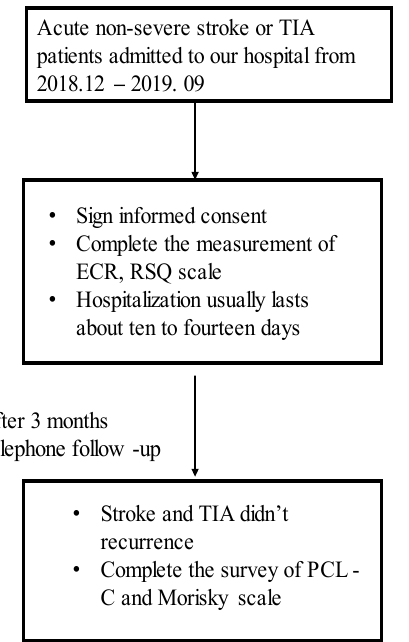
Figure 1. The study flow diagram.